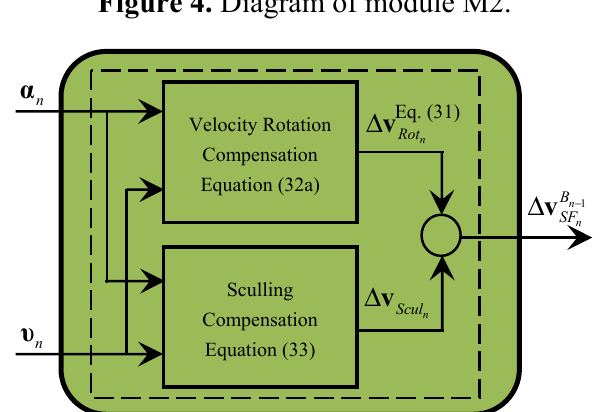
Figure 4. Diagram of module M2.